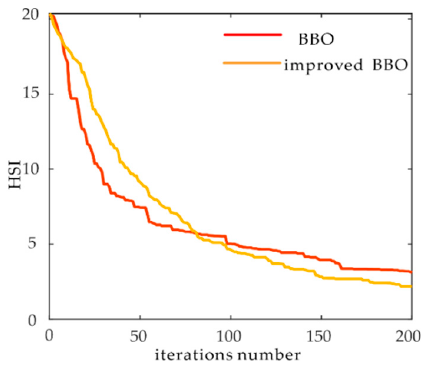
Figure 10. Equations 15 and 16 experimental results.